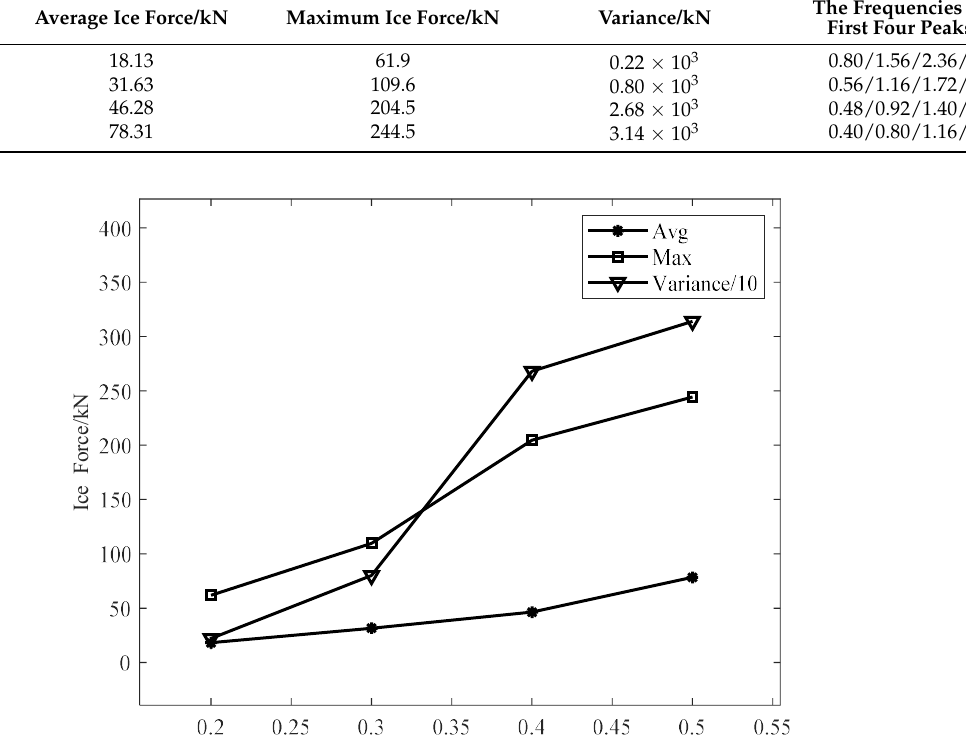
Figure 18. Change trend of variance and ice force with ice thickness (hi).